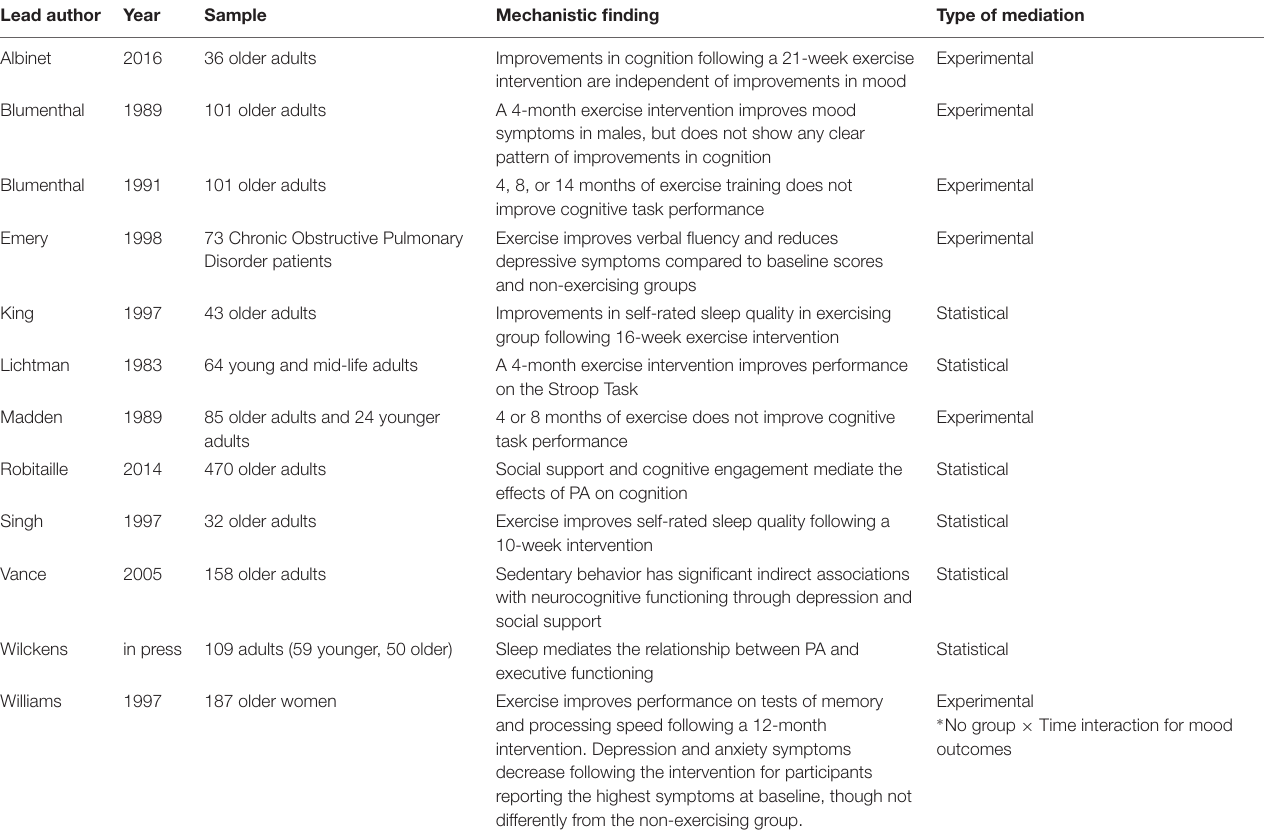
TABLE 2 | Evidence for mechanisms of PA at Level 3 of